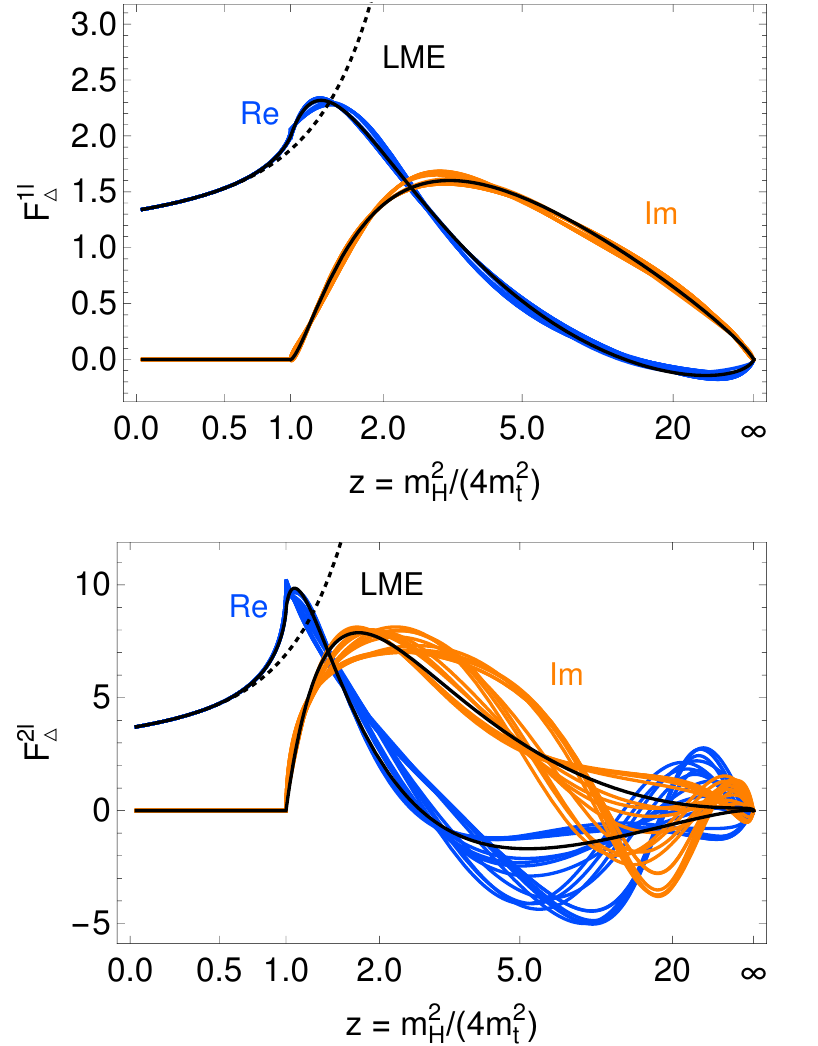
Figure 3 . Pad(cid:19)e approximants for F 4 at LO (top) and NLO (bottom) constructed using only the LME up to the order 1 =m 8 as input. Shown are the real/imaginary part of the Pad(cid:19)e approximants t (blue/orange) and the exact results (black). We constructed in total 20 approximants of the types [1/3], [2/2] and [3/1] for random values of a R in the range [0.1,10], while approximants with poles in the rectangle Re( z ) 2 [0 ; 8] and Im( z ) 2 [ (cid:0) 1 ; 1] have been excluded since they can cause unphysical resonances in the form